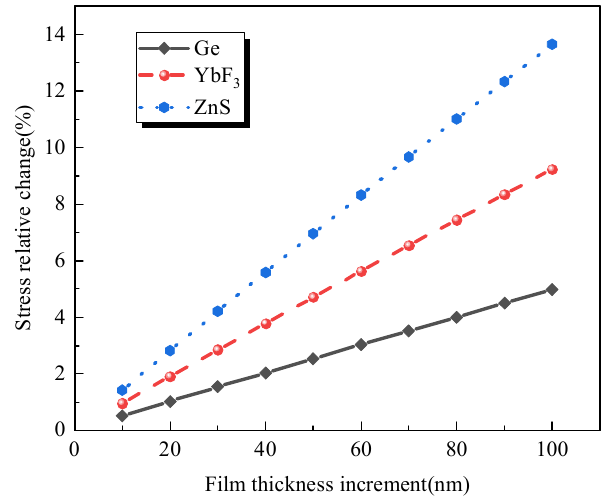
Figure 2. The relative change in the total film stress with the film’s physical thickness.